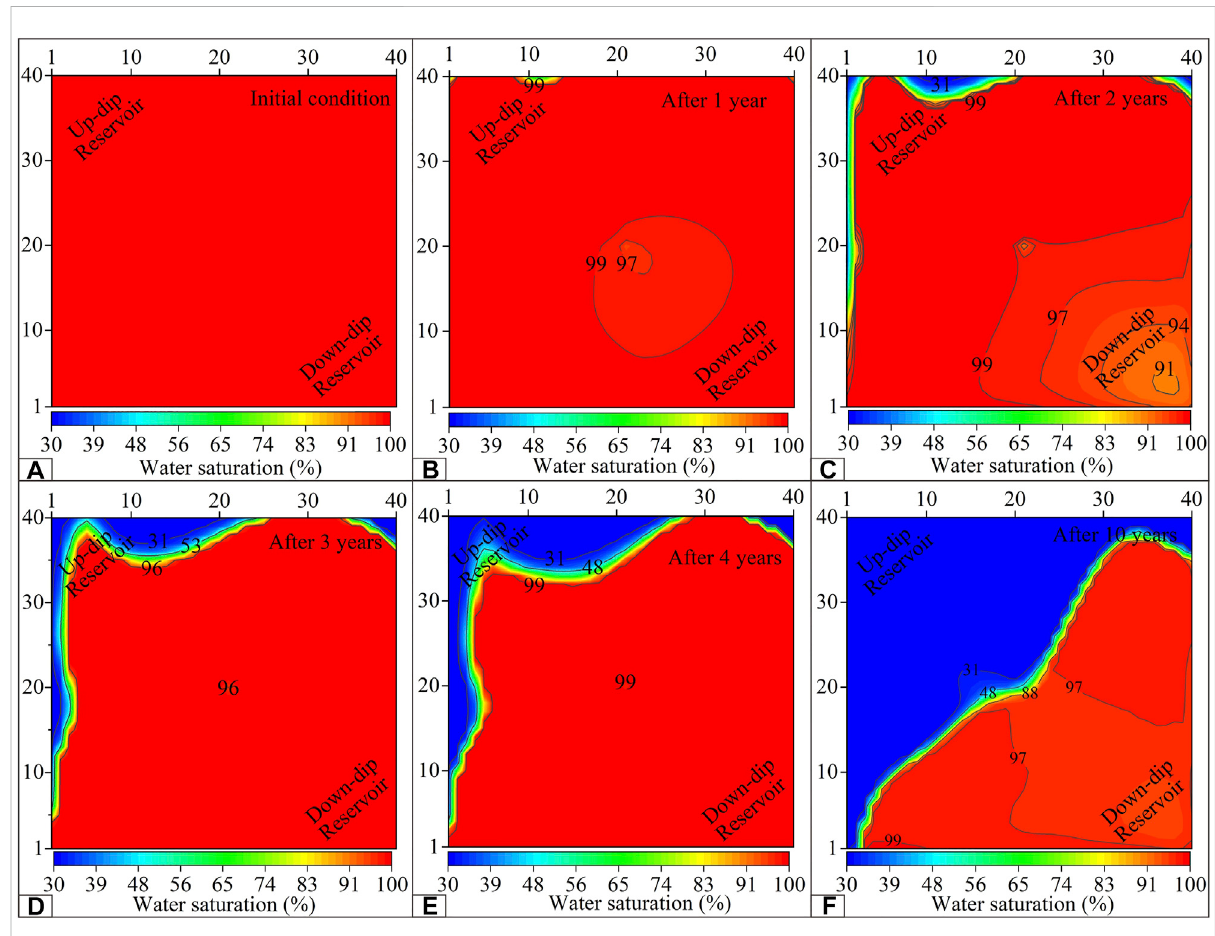
FIGURE 9 (A) Initial water saturation distribution ofASIM. (B) Watersaturationdistributionafter 1 year ofdrainage inASIM. (C) Water saturation distribution after 2 years of drainage in ASIM. (D) Water saturation distribution after 3 years of drainage in ASIM. (E) Water saturation distribution after 4 years of drainage in ASIM. (F) Water saturation distribution after 10 years of drainage in